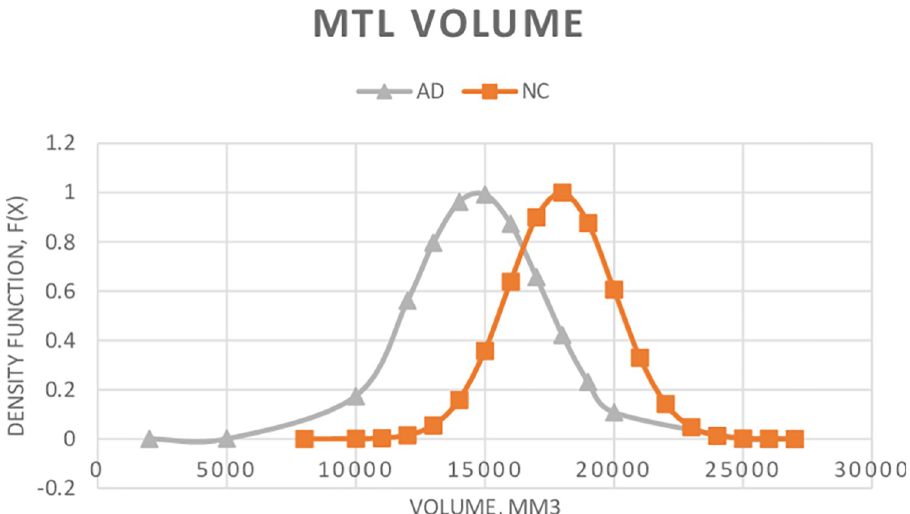
Fig 4. Probability density distributions of total volumes of the medial temporal lobe (MTL): Normal controls (NC) vs Alzheimer’s disease (AD). The mean volumes ( ± SD) of NC and AD are 17944 ( ± 2053) mm 3 and 14697 ( ± 2522) mm 3 , respectively.